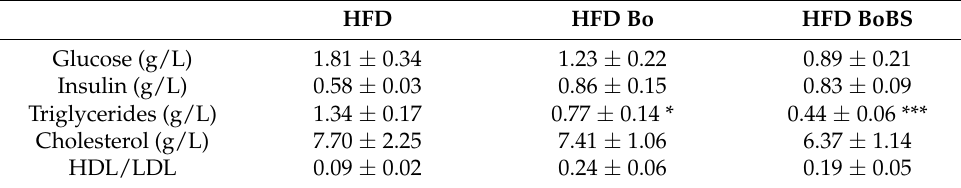
Table 2. Carrot supplementation impacts on plasma glucose and lipid parameters.